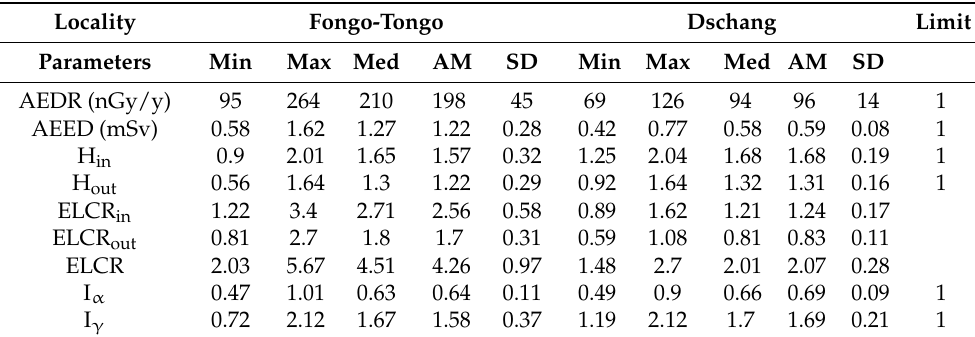
Table 5. Summary of the different radiological parameters obtained by in situ. Locality Fongo-Tongo Dschang Limit Parameters